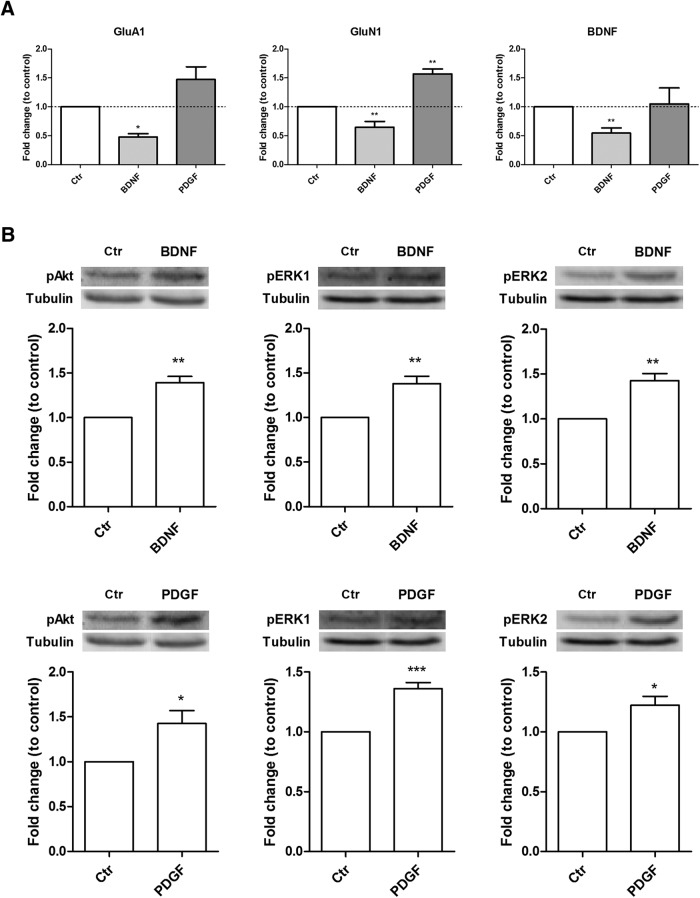
BDNF signaling specifically induces the release of mRNAs from hnRNP K-containing complexes at synaptic sites. A, Effect of BDNF and PDGF on the interaction of GluA1, GluN1, and BDNF mRNAs with hnRNP K in synaptoneurosomes. The relative abundance of each mRNA coimmunoprecipitated with hnRNP K was evaluated by qPCR. Results are the mean ± SEM of four different experiments performed in independent preparations, and are expressed as fold change to control; *p < 0.05, **p < 0.01, as determined by one-way ANOVA followed by the Dunnett’s multiple comparison test. Activation of Akt and ERK1/2 by BDNF (B) and PDGF (C) in hippocampal synaptoneurosomes. Graphs represent the fold change in the levels of pAkt, pERK1, or pERK2 in hippocampal synaptoneurosomes stimulated with BDNF (50 ng/ml) or PDGF (20 ng/ml) for 10 min. Representative Western blotting images showing the results obtained for the phosphorylated proteins and tubulin under control conditions and following stimulation with BDNF or PDGF, as indicated. The results represent the quantification of six to nine experiments performed in independent preparations, and are expressed as fold change (mean ± SEM) to control; *p < 0.05, **p < 0.01, ***p < 0.001 as determined by the Student’s t test.